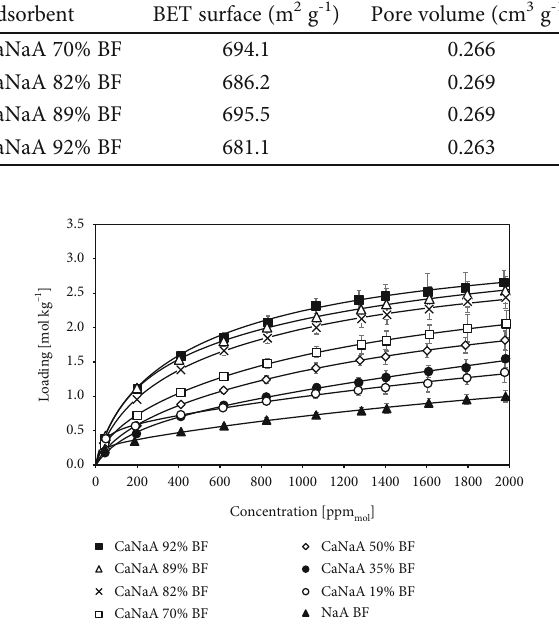
Figure 4: H S adsorption isotherms on LTA zeolites of di ff erent 2 cation exchange degrees at 25 ° C.